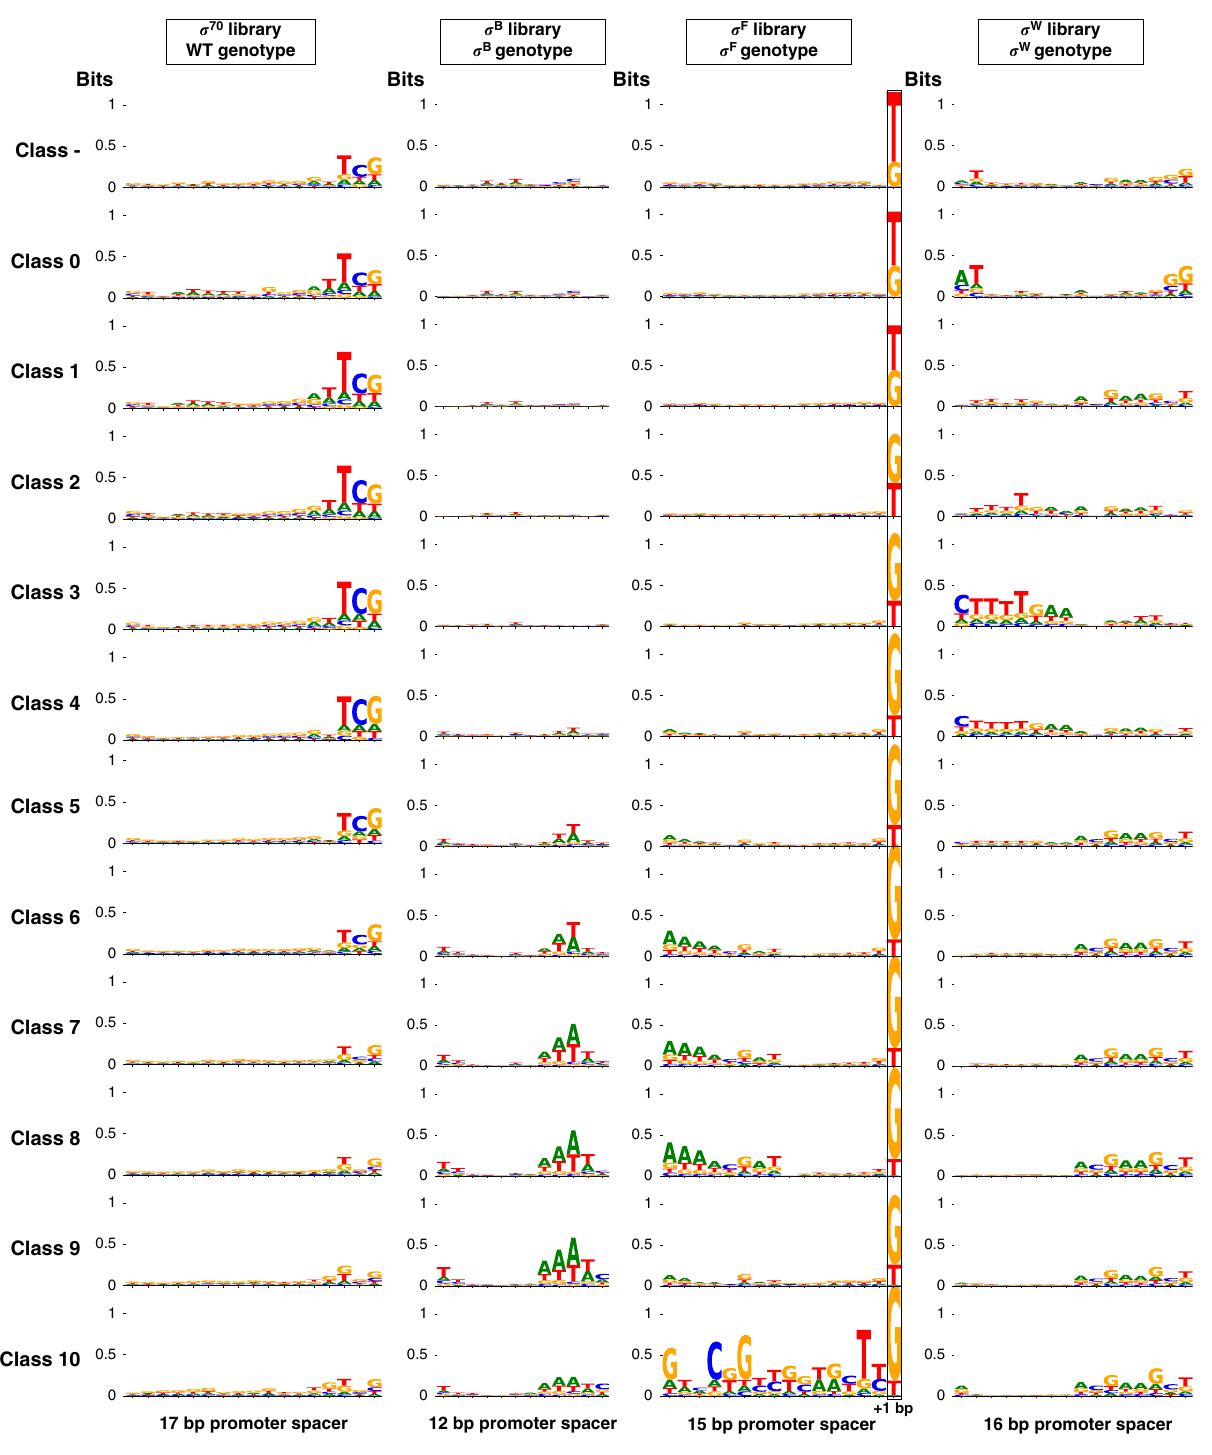
Fig. 3 Sequence logos illustrating the promoter spacer motifs, situated between the conserved − 35 and − 10 regions. These are given for each of the bins in which the Escherichia coli sigma factor 70 ( σ 70 ) and Bacillus subtilis σ B , σ F , and σ W -speci fi c promoter libraries, in presence of their cognate σ , were sorted. Classes 0 – 10 represent the promoters ranging from the lowest to the highest expression. In case of the σ F library, one engineered base pair following the spacer is situated within the − 10 conserved promoter region 56 ). Motifs were created with WebLogo3.6.0 83 , using the fi ltered data sets (WT